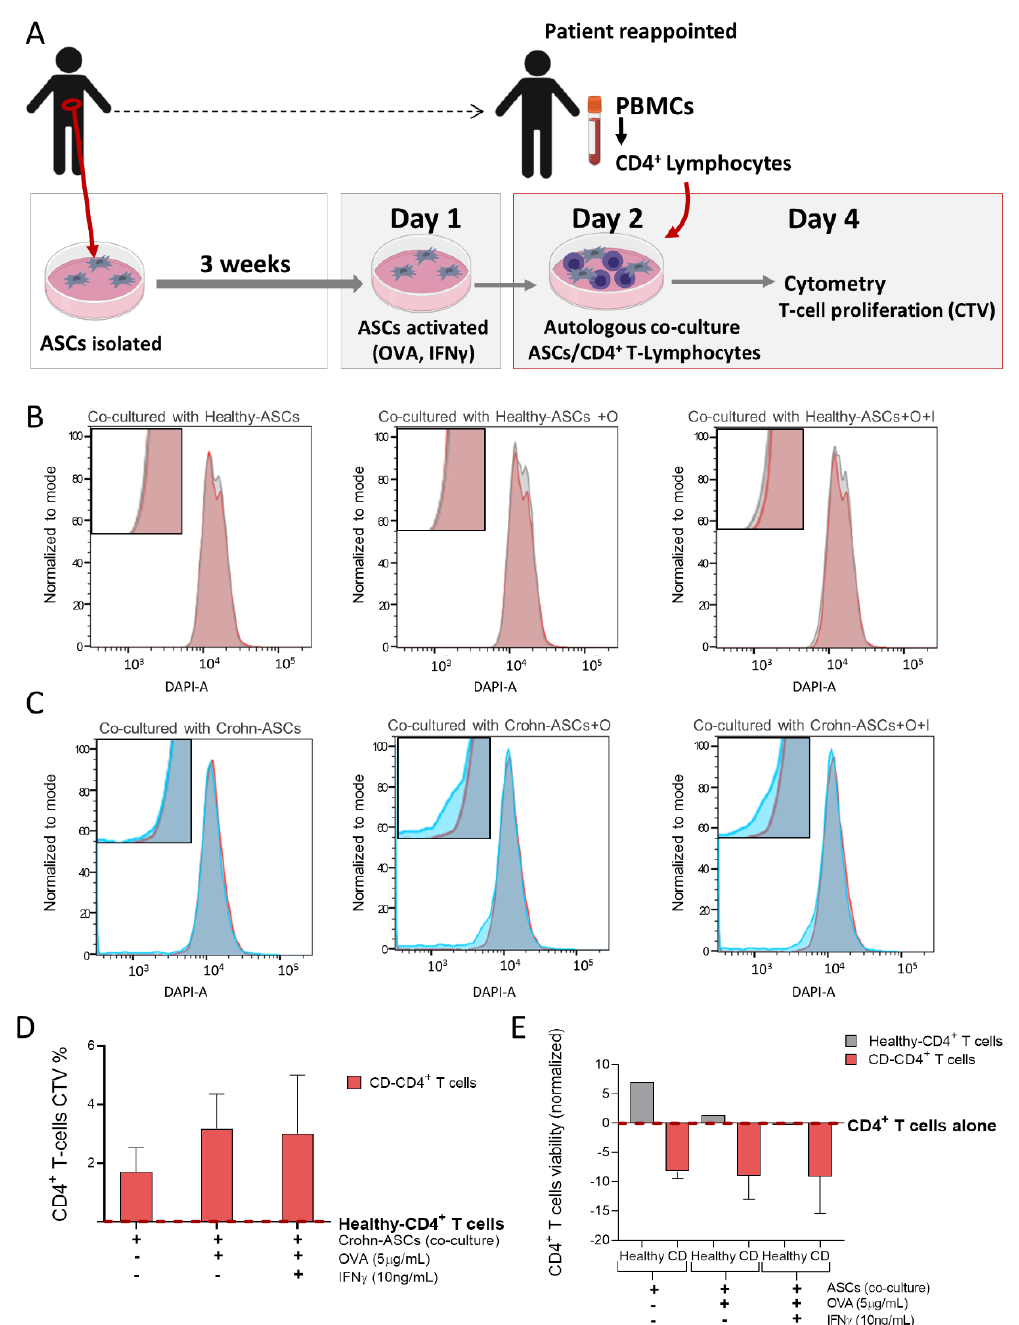
Figure 6. Creeping fat-derived ASCs act as antigen-presenting cells. ( A ) Schematic representation of the antigen-presentation assay. CD4 + T-lymphocytes were co-cultured with autologous healthy- and Crohn’s disease-derived ASCs, from visceral and mesenteric adipose tissue, respectively. T-cell proliferation was measured by CellTrace violet dye (CTV) intensity after two days of co-culture with untreated ASCs, and ASCs pulsed with ovalbumin (OVA), in the presence or absence of IFN γ . ( B , C ) Representative histograms for healthy- and Crohn’s Disease-derived CD4 + T-lymphocytes alone (grey and dark blue, respectively) and CD4 + T-lymphocytes co-cultured with healthy- and Crohn’s Disease -derived ASCs (red and lighter-blue, respectively). ( D ) Crohn’s Disease -derived CD4 + T- lymphocytes’ ( n = 3) proliferation relative to healthy control. ( E ) Healthy- and Crohn’s Disease -derived CD4 + T- lymphocytes’ viabili ty relative lo lymphocytes alone. Abbreviations: CD, Crohn’s disease; INFγ and I, Interferon gamma; O and OVA, ovalbumin; PBMCs, peripheral blood mononuclear cells; VAT, visceral adipose tissue; SAT, subcutaneous adipose tissue. Data are expressed as the mean ± SEM.